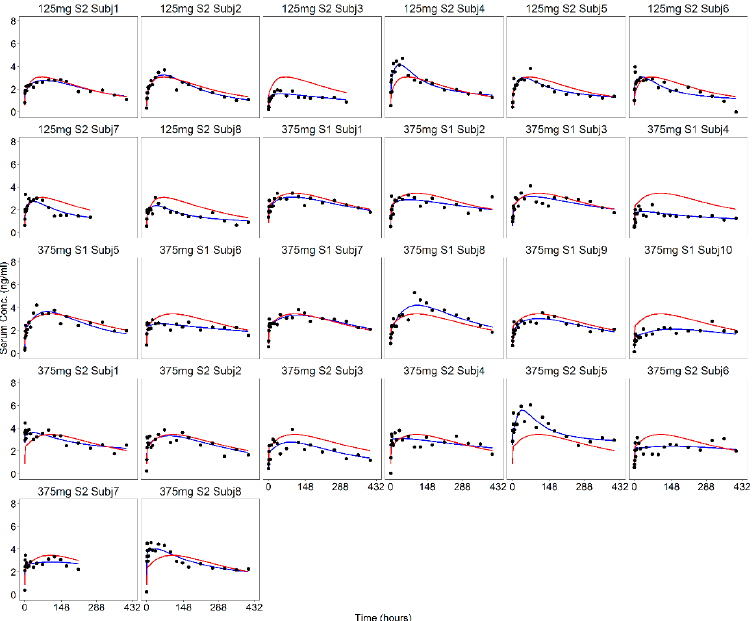
Figure 6. Model predictions of the individual (blue lines) and population (red lines) serum concen- tration profiles at 125 and 375 mg dose levels together with observations (black dots).